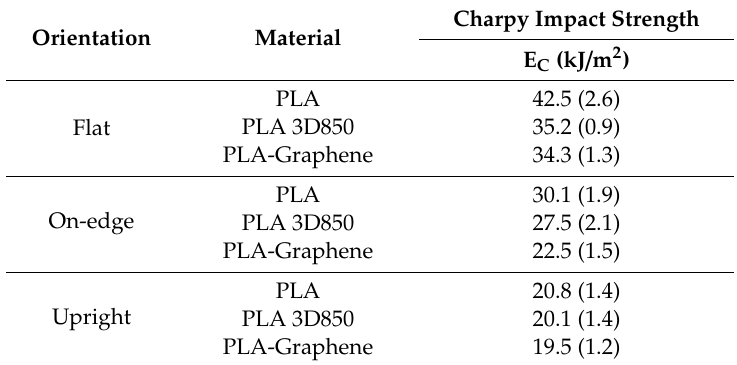
Table 4. Average Charpy impact strength results of PLA, PLA 3D850 and PLA-Graphene samples for Flat, On-edge and Upright orientation. Standard deviation is depicted in brackets